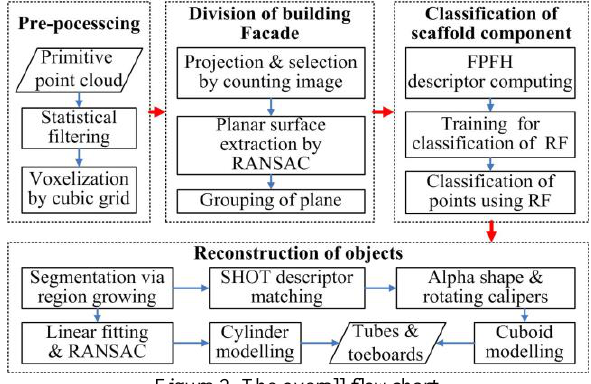
Figure 2. The overall